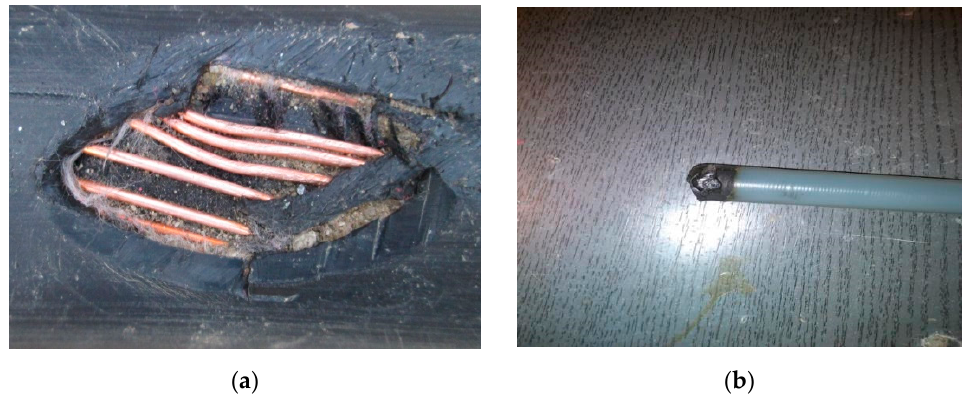
Figure 5. Visualization of the place of breakdown of the insulation: ( a ) after the removal of the outer shell; ( b ) after the removal of the semiconductor layer.